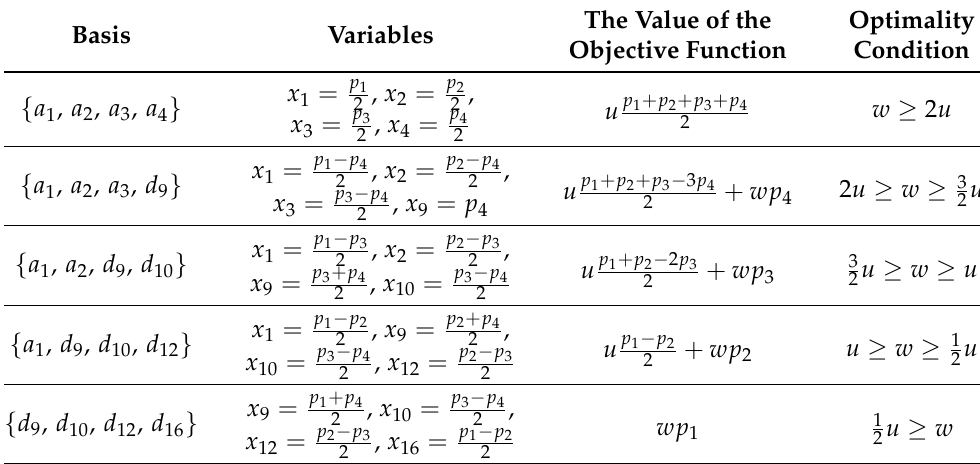
Table 1. The optimal solutions, i.e., distances between ( 0,0,0,0 ) and ( p 1 , p 2 , p 3 , p 4 )